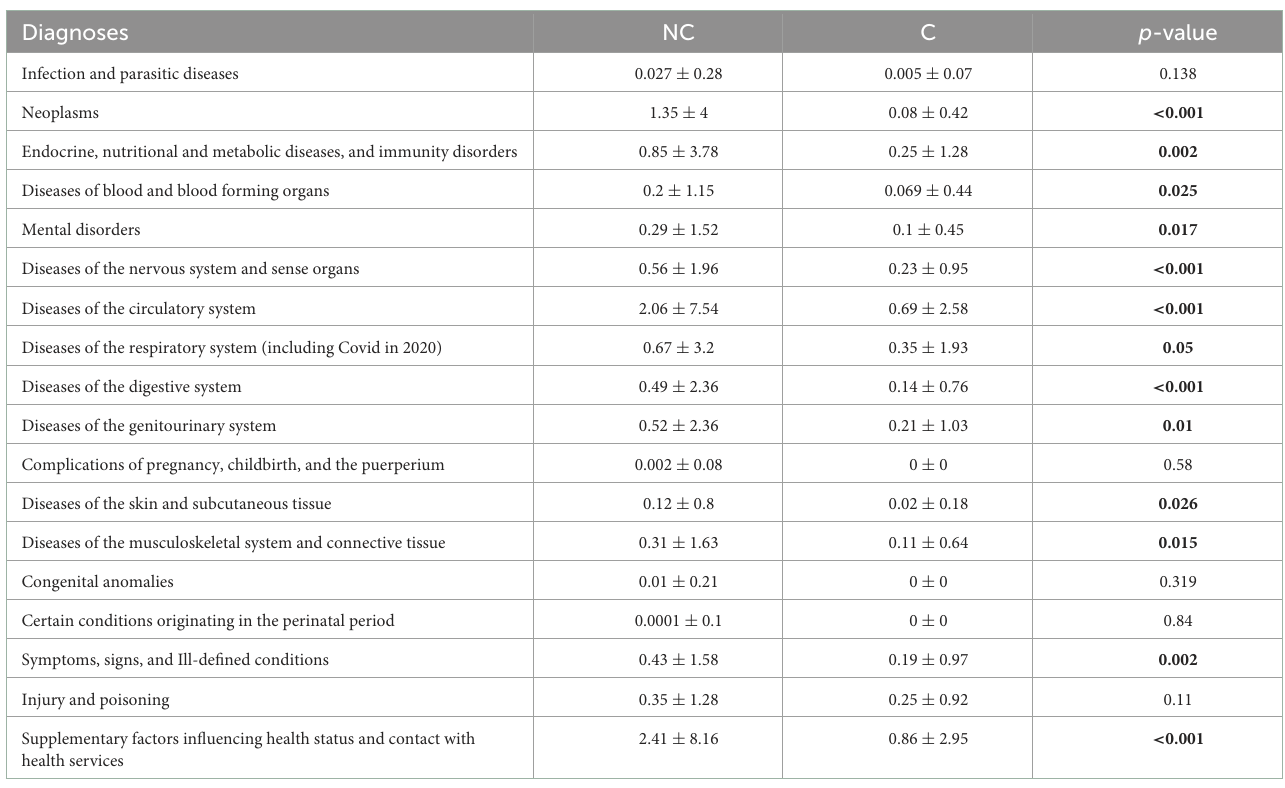
TABLE 2 Total diagnoses for centenarians and non-centenarians. Mean ±